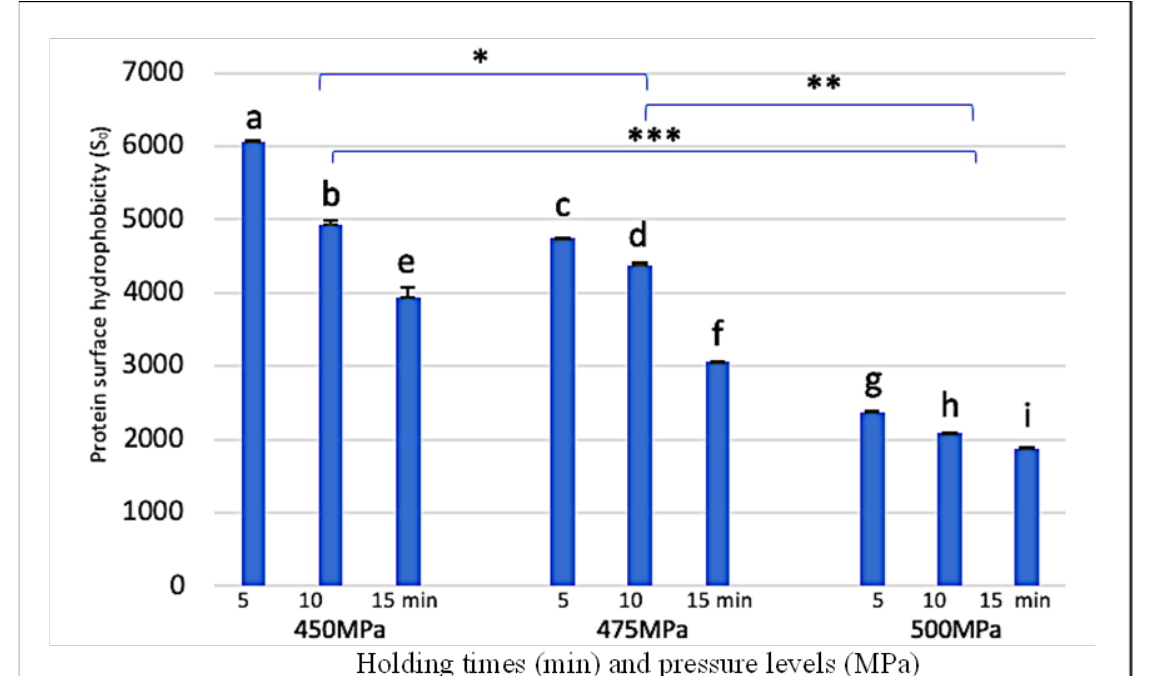
Figure 3. Effect of high-pressure and time on surface hydrophobicity of strawberry-flavoured egg- white pudding. Different lowercase letters are significant different (p < 0.05). Different stars (*,**,***) indicate significant differences ( p < 0.05) between group of high pressure levels.